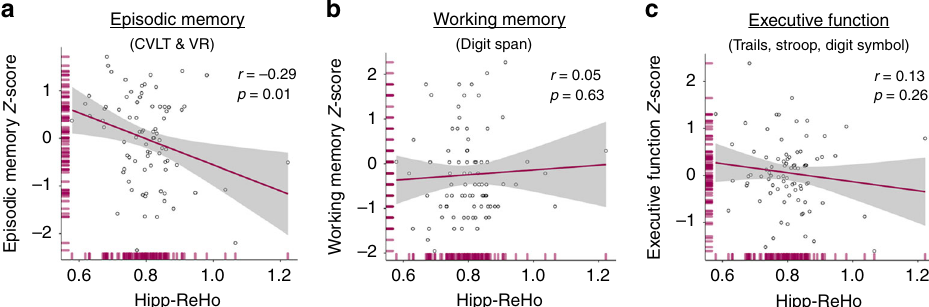
Fig. 6 Hipp-ReHo predicts episodic memory but not working memory or executive function. a Higher hipp-ReHo predicted worse episodic memory performance ( r = − 0.29, p = 0.01; all r and p -value pairs re fl ect Pearson correlation;). In a multiple regression, hipp-ReHo remained a signi fi cant predictor of memory ( p = 0.046) after adjusting for age, sex, hippocampal volume and global PiB DVR, but was trending ( p = 0.094) in a model that included ERC FTP SUVR, which was also trending ( p = 0.070). b , c There was no signi fi cant relationship between hipp-ReHo and working memory ( r = 0.05, p = 0.63) or executive function ( r = − 0.13, p = 026). Source data are provided as a Source Data fi le. ReHo regional homogeneity, hipp-ReHo hippocampal ReHo,